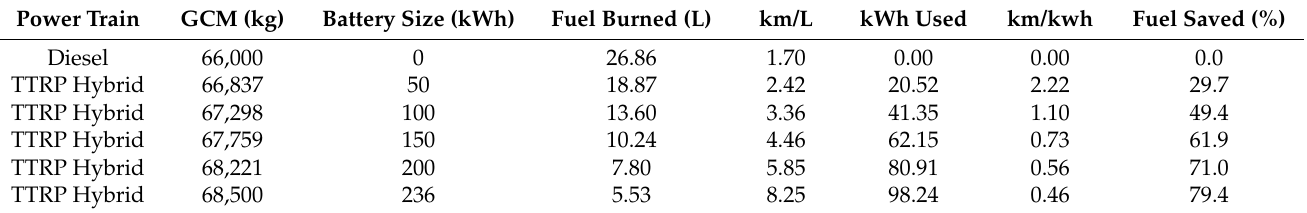
Table 10. Drive cycle 5